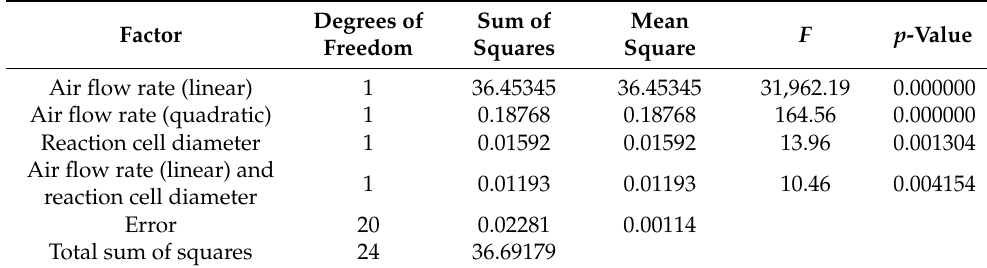
Table 12. Results of the analysis of variance applied to the internal pressure in the reaction cell with upper air inlet and outlet